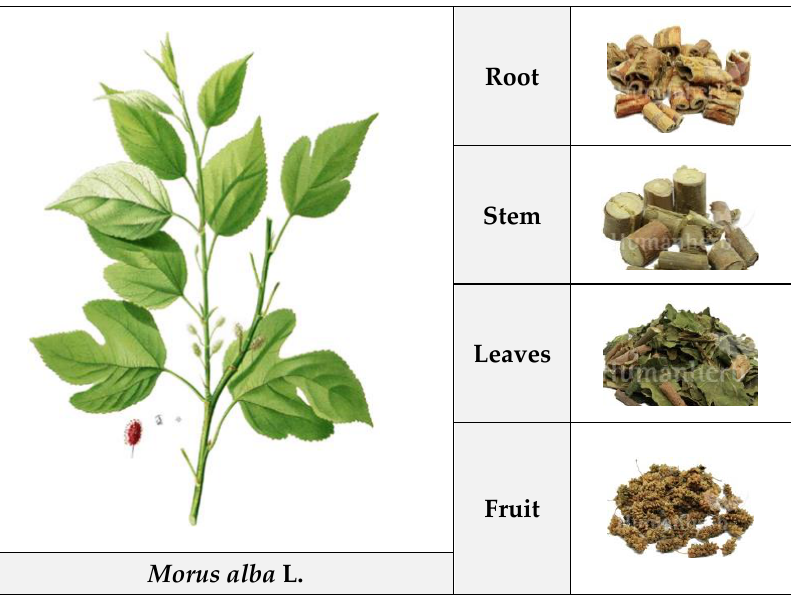
Figure 1. Morphology of Morus alba L.